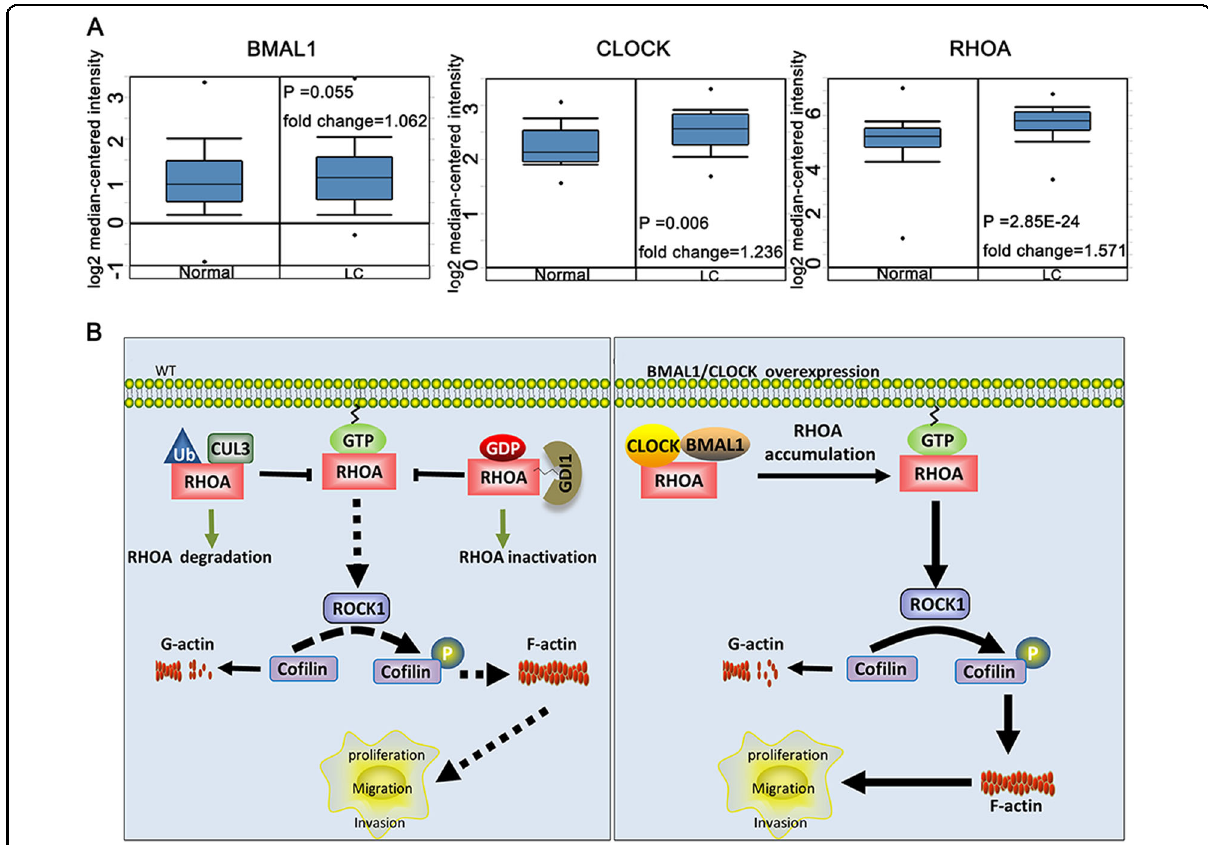
Fig. 8 A schematic of the regulation of the RHOA-ROCK-CFL pathway by CLOCK and BMAL1 in tumor cells. a Analysis of BMAL1, CLOCK, and RHOA in liver cancer ( ONCOMINE database). Box plots derived from gene expression data in ONCOMINE in normal and liver cancer tissue. The p value was set up at 0.01, and the fold change was de fi ned as 2; LC liver cancer. b A schematic diagram depicting the regulatory effects of CLOCK and BMAL1 on F-actin/G-actin turnover and its role in cell proliferation, migration, and